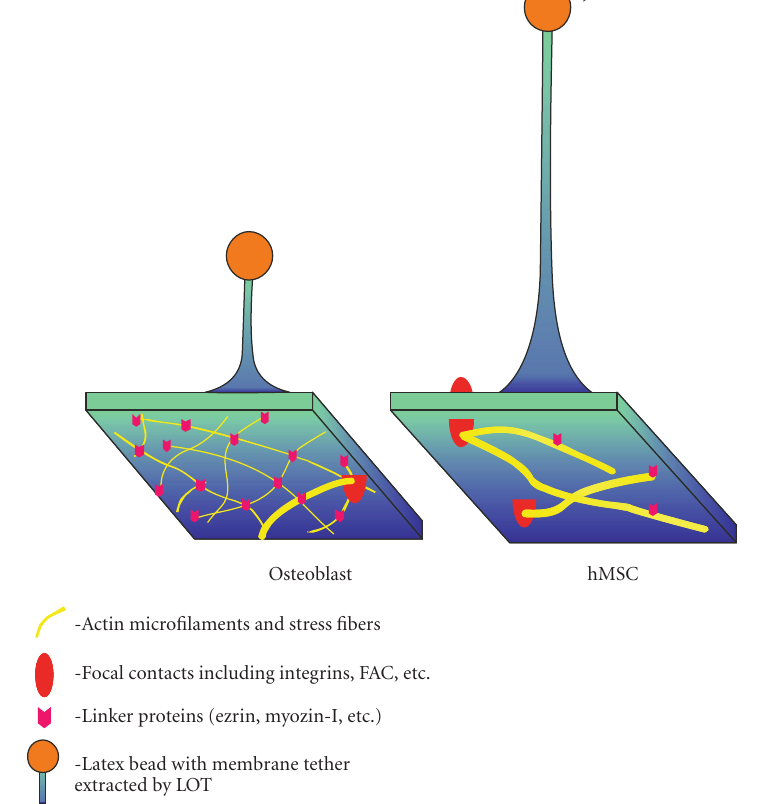
Figure 4: Model for di ff erential cellular mechanics in human MSCs and osteoblasts. Thin and dense actin filaments in osteoblasts are tightly bound to the plasma membrane through multiple linker proteins (e.g, ATP-dependent ERM proteins) and focal complexes. Thicker stress fibers in human MSC are associated with the membrane mostly at the focal contacts due to a smaller contact area with the membrane and thus lower availability of protein linker binding sites. As result, in human MSC the overall membrane-cytoskeleton adhesion is weaker, and longer membrane tethers are formed that reflects a lower membrane tension. However, thick bundled actin structure in human MSCs provides a higher elastic